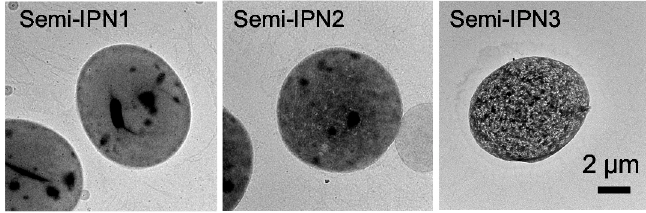
Figure 7. TEM images of semi-IPN with different initiator amounts (samples were labeled with uranyl acetate).